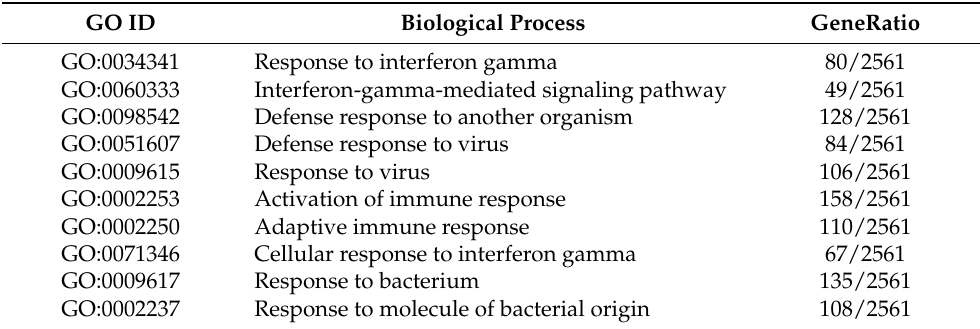
Table 5. Top 10 biological processes significantly (padj ≤ 0.01) enriched in genes differentially expressed in M1_B versus M1_A macrophages.